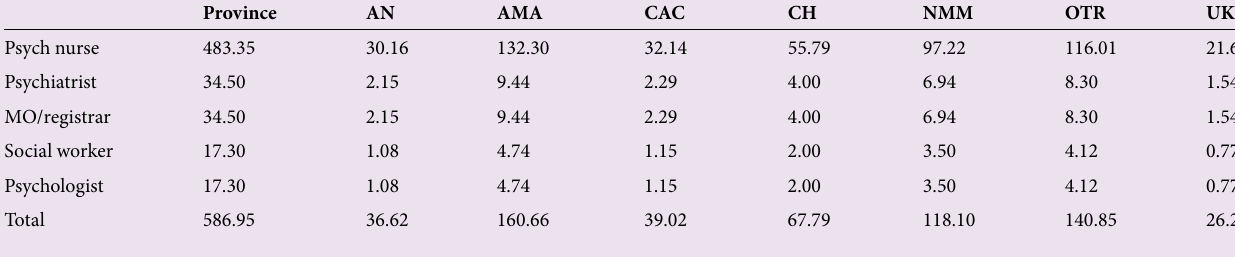
Table 8. Staff requirements for an acute psychiatric service